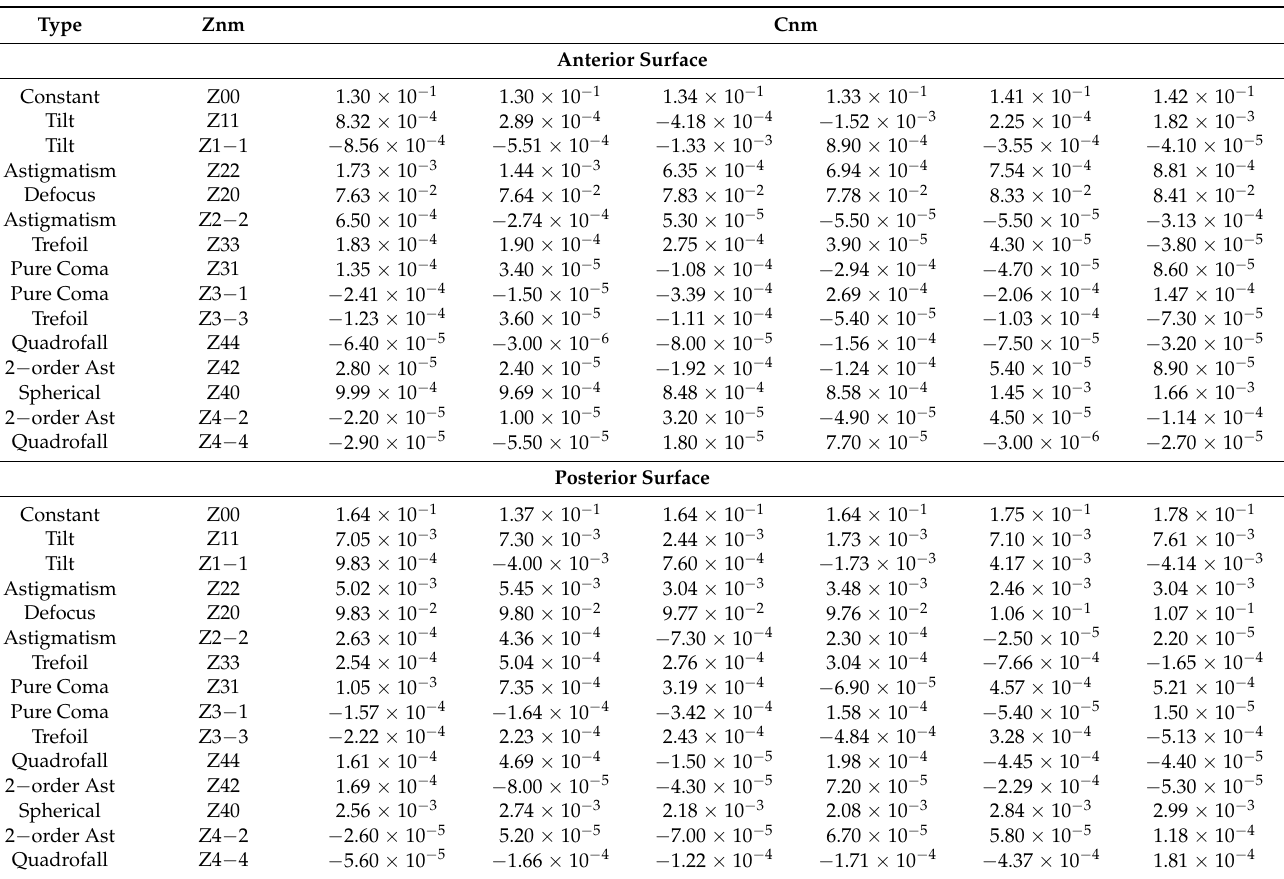
Table A1. Values of Zernike Weight Coefficients on the Anterior and Posterior Surface of the Cornea in the Diagnosis of Low